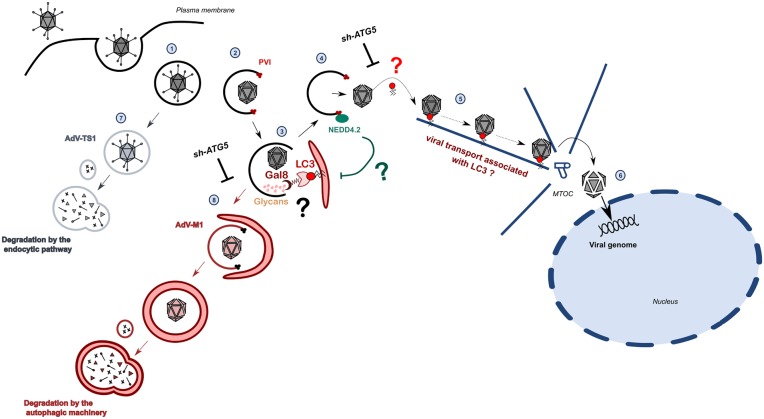
Model for adenovirus control of autophagic processes upon entry.AdV enter cells by receptor-mediated endocytosis (1) followed by partial disassembly to release the internal membrane lytic capsid protein PVI (2). PVI release initiates membrane rupture and intralumenal glycans are recognized via galectins and the autophagic machinery is recruited through Gal8 and LC3 to the damaged endosome mediated by yet to clarify adapter molecules (3). The recruitment of Nedd4.2 via the PPxY motif in PVI prevents formation of autophagosomes via an unknown mechanisms and facilitates endosomal escape (4). Endosomal escape involves the autophagic machinery because ATG5 depletion affects dissociation of virus from damaged vesicle. Dynein motor complexes are also required to access cytosolic microtubule mediated transport towards the MTOC which may occur in association with LC3 (5). Subsequent genome release occurs at the nuclear pore complex (6). Genome delivery is delayed upon ATG5 depletion. If PVI is not released (AdV-TS1), no membrane damage occurs and viruses are degraded via lysosomal sorting (7). If PVI is released and membrane damage occurs but the virus does not escape (AdV-M1), capsids are degraded via autophagy (8). This degradation is limited in absence of functional autophagy (e.g. upon ATG5 depletion).